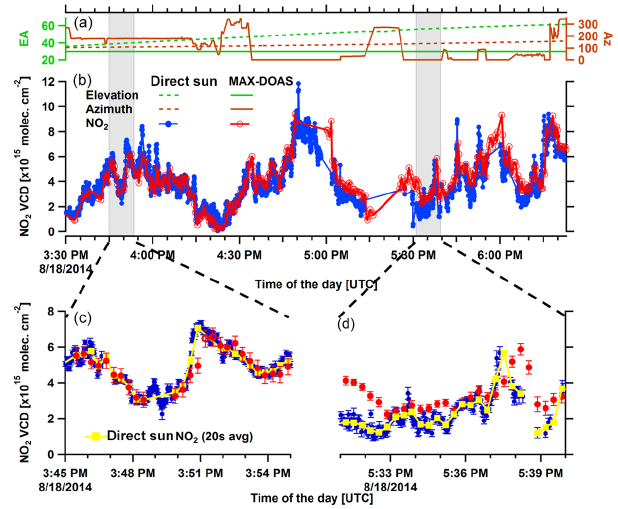
Figure 7. Measurements of NO 2 VCD aboard the mobile labora- tory during the RD 14 on 18 August 2014 in northern Colorado. (a) The EA (green) and the Az (brown) angles for the DS-DOAS (dashed) and MAX-DOAS (solid). (b) Time series of NO 2 VCD measured by the DS-DOAS (blue) and the MAX-DOAS (red). Pan- els (c) and (d) show expansion into two 9min period (grey boxes) when (i) difference in EA and Az between the two instruments was ∼ 10 ◦ and ∼ 70 ◦ and (ii) difference in EA and Az was ∼ 25 ◦ and ∼ 140 ◦ . The yellow line represents the DS-DOAS data averaged to the MAX-DOAS timestamp. Note that the MAX-DOAS instrument was acquiring a zenith reference spectrum at 15:49 for 60s. The open red circles in panel (c) represent the MAX-DOAS data point which did not pass the root-mean-square-based quality control but was included for comparison purposes. The error bars in panel (c) and (d) represent 1 σ fit